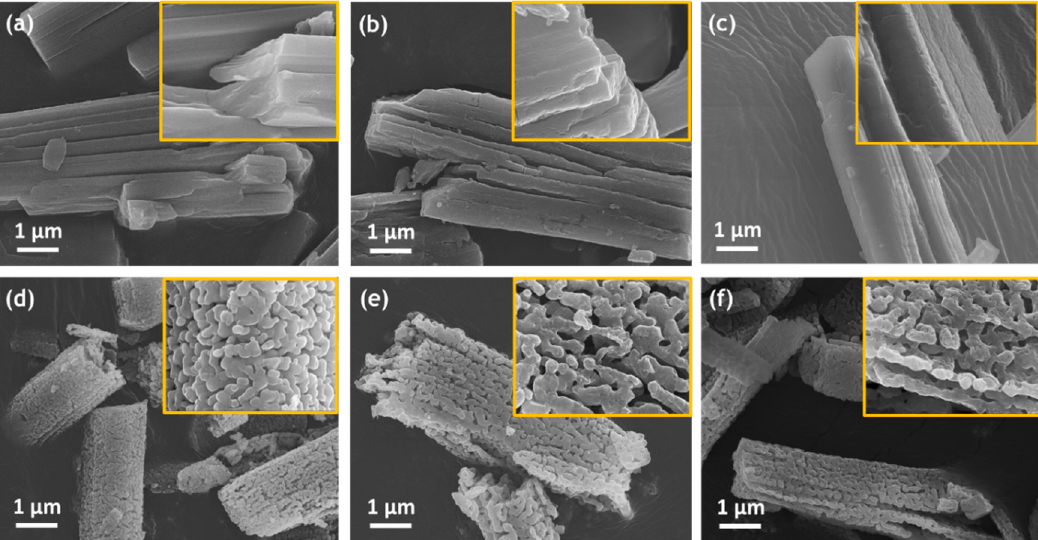
Figure 5. SEM images of Ca-MOF-24h-1 as-synthesized and calcined at different temperatures. ( a ) As-synthesized: ( b ) C150; ( c ) C300; ( d ) C500; ( e ) C600; ( f ) C750.